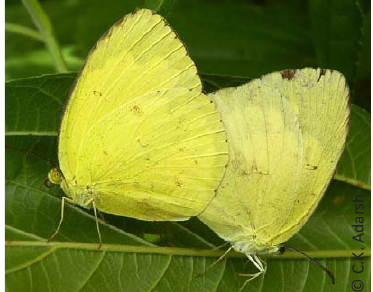
Image 15. Eurema blanda Three-spot Grass Yellow